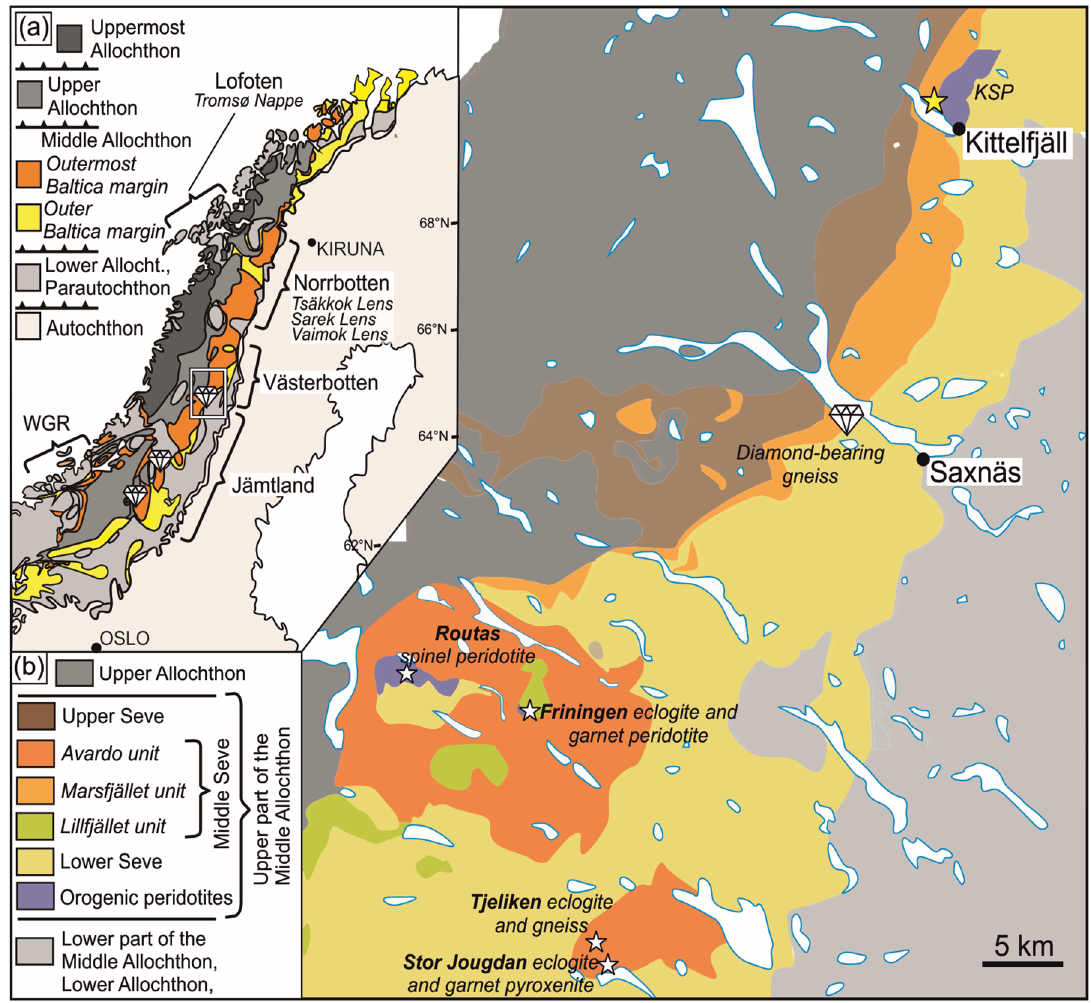
Figure 1. Geological map of the study area: ( a ) Simplified tectonostatigraphic map of the Scandinavian Caledonides (after Gee et al., [6]). The diamond symbols indicate localities within the Seve Nappe Complex with confirmed metamorphic microdiamonds, i.e., from south to north: Tväråklumparna [14], Åreskutan [15] and Saxnäs [15,16]. The rectangle shows the area presented on map ( b ). Abbreviations: Western Gneiss Region (WGR). ( b ) A simplified tectonostratigraphic map of the northern Jämtland/southern Västebotten area. The yellow star marks the sampling area within the high-grade Marsfjället unit.